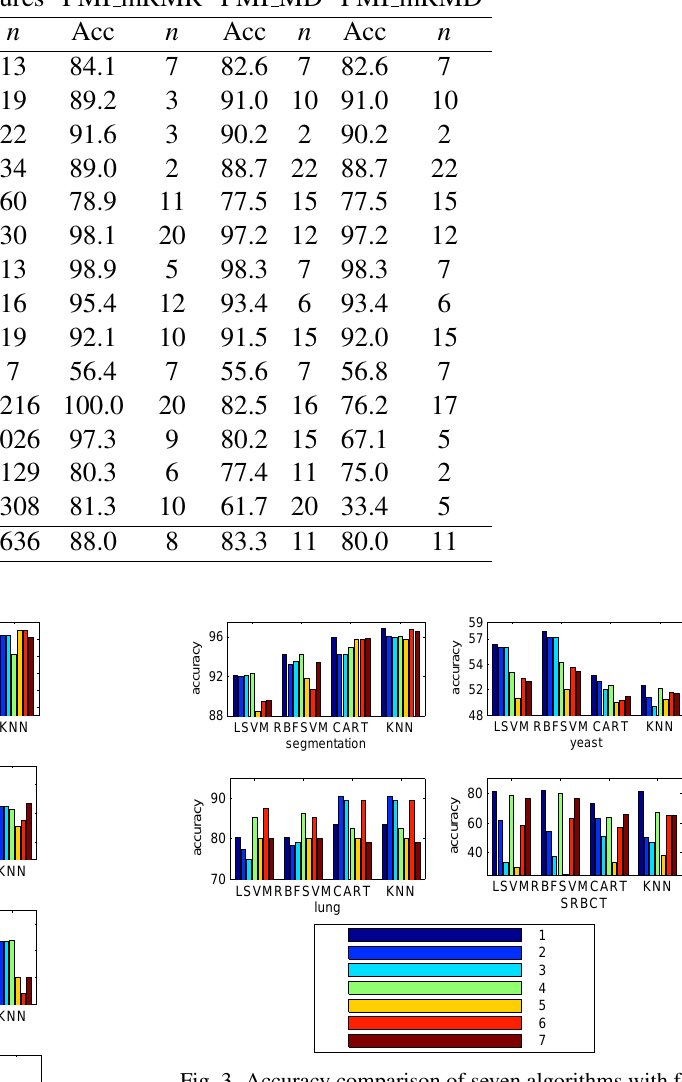
Fig. 3. Accuracy comparison of seven algorithms with four classifiers. ’1’ denotes FMI mRMR, ’2’ denotes FMI MD, ’3’ denotes FMI mRMD, ’4’ denotes MI mRMR, ’5’ de- notes CFS, ’6’ denotes FCBF and ’7’ denotes